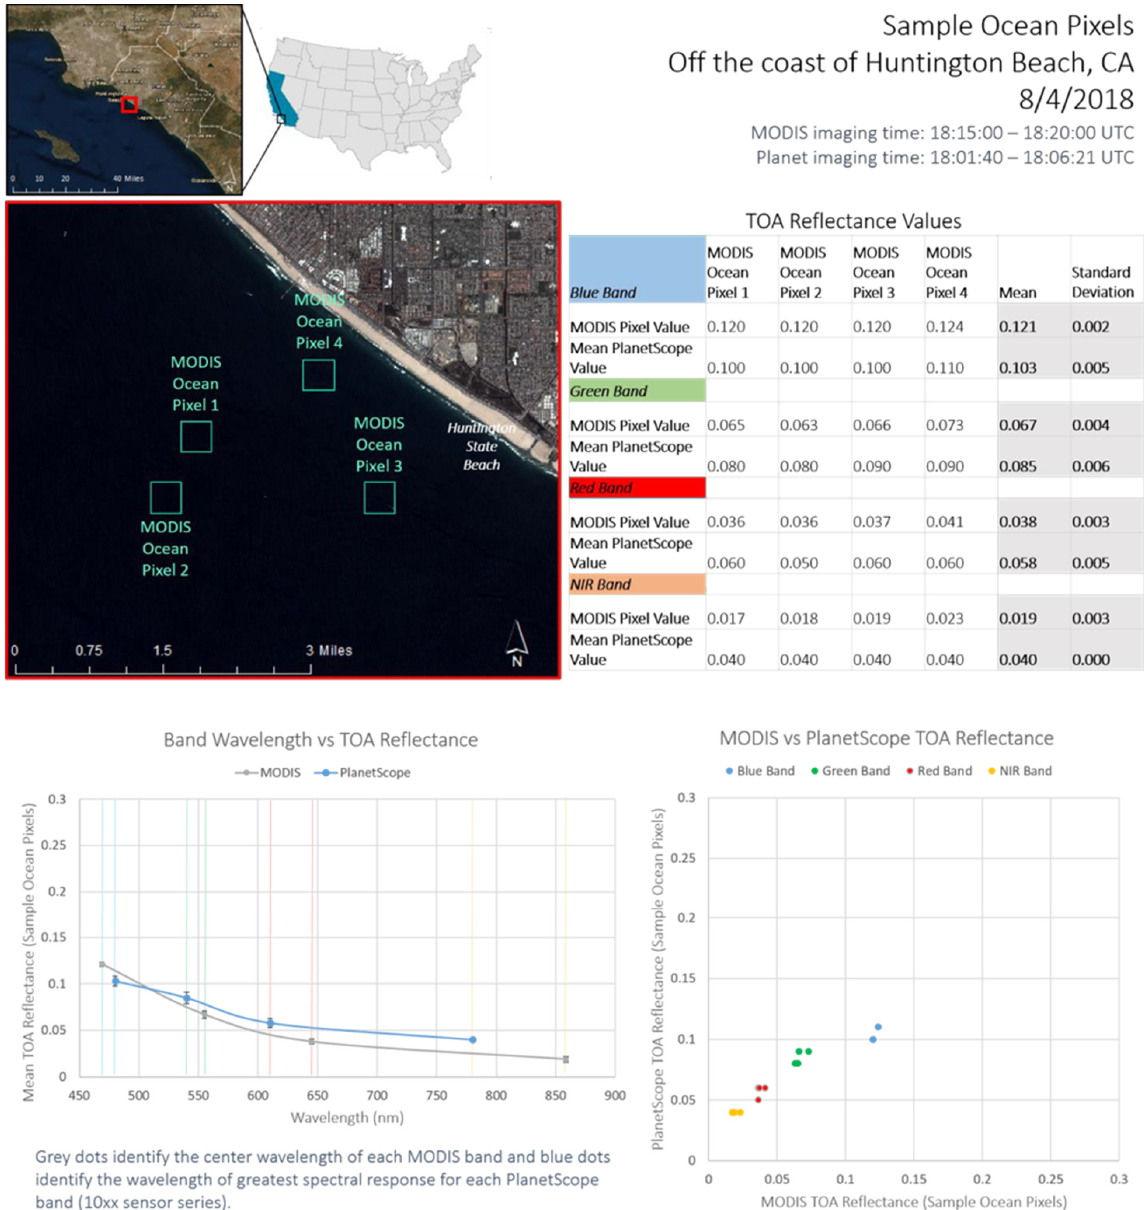
Figure A4. Results from Section 3.2 for pixels sampled over the ocean in the Los Angeles study area on 8/4/2018.